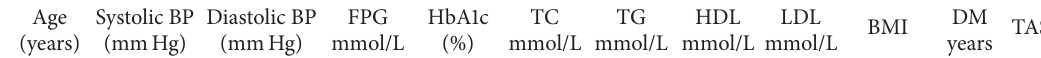
Table 3: Correlation analysis matrix showing covariability between the study continuous